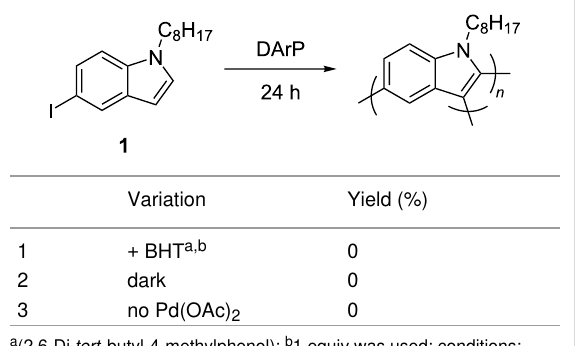
Table 1: Polymerization control